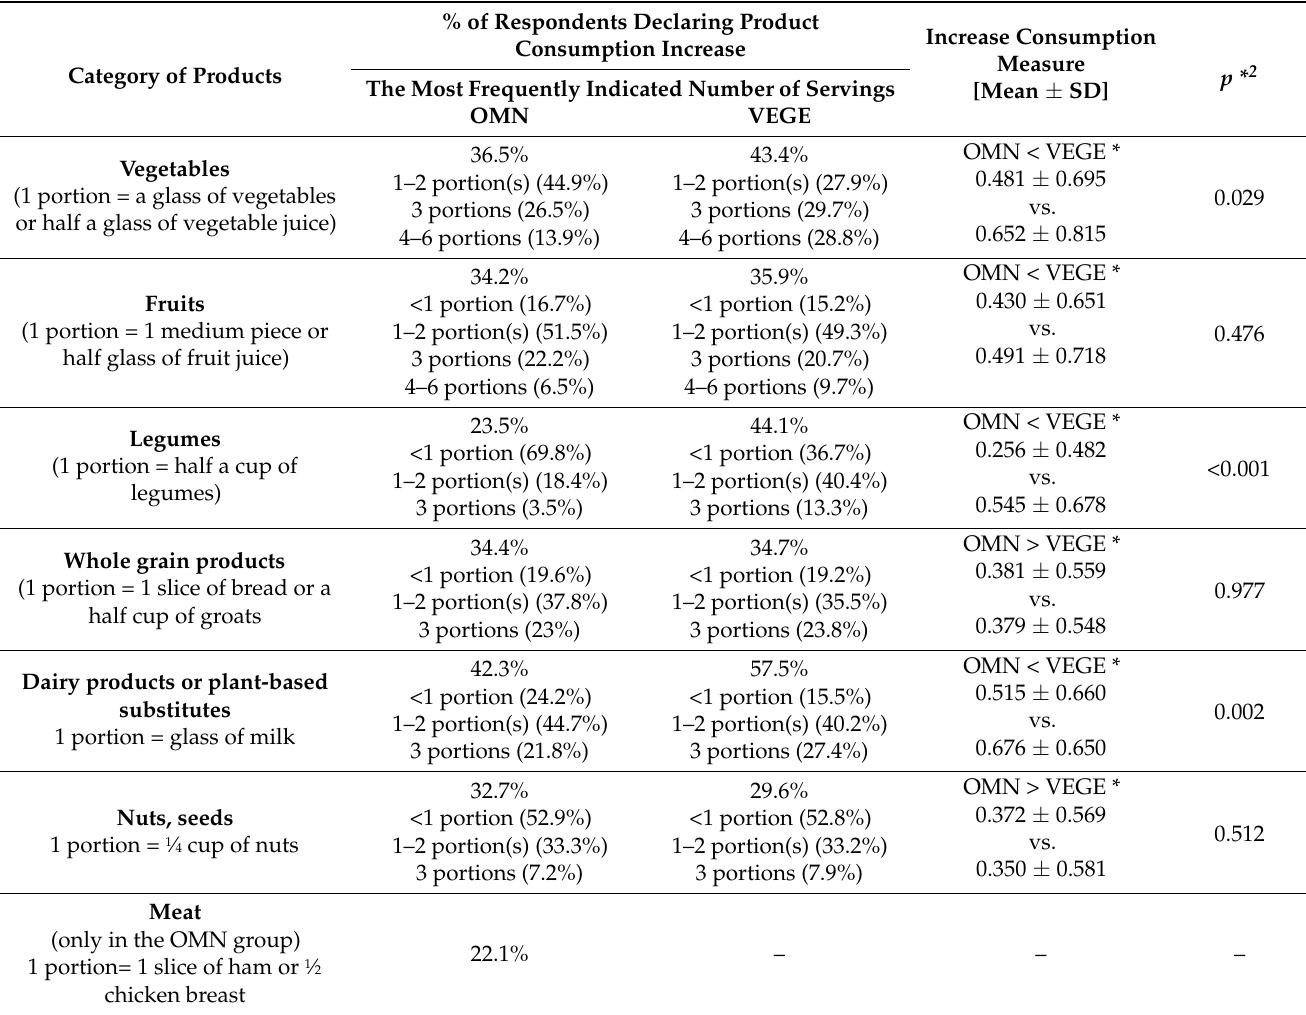
Table 10. Increasing product consumption during a pandemic, together with estimating the daily portion